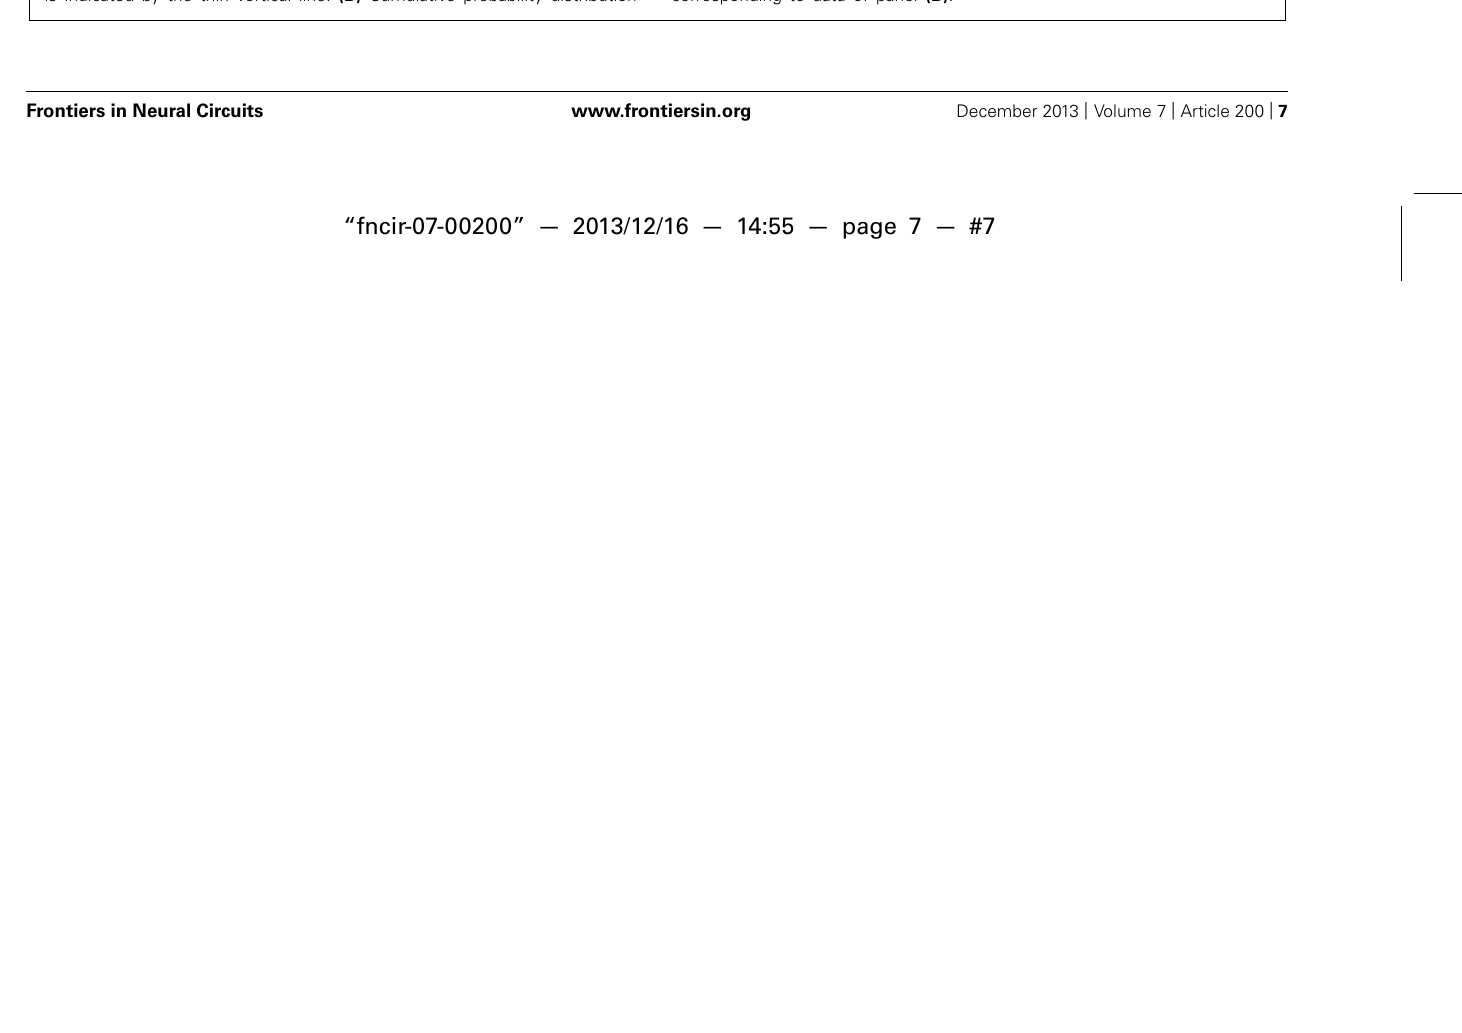
FIGURE 6 | Reaction time distribution shifts with penalty change. (A) Cumulative probability distribution of reaction times for rat performing the exemplar discrimination (black lines in Figure 5 ), with short penalty (solid curve) or long penalty (dashed curve). Median reaction time increased from 0.724 to 0.787 s. The rat’s lifetime minimum reaction time is indicated by the thin vertical line. (B) Cumulative probability distribution